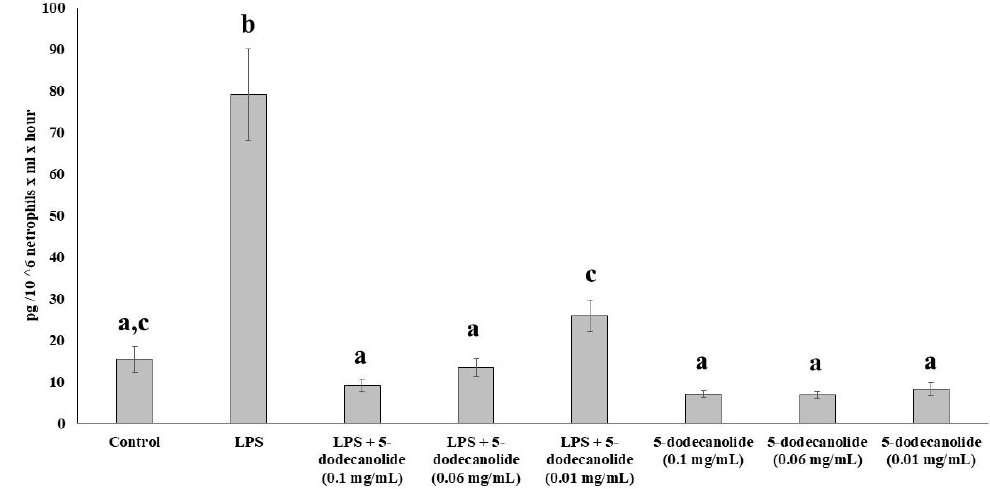
Figure 6. Effects of 5-dodecanolide in neutrophil TNF α production. Statistical analysis: One-way ANOVA test. Different letters indicate significant differences between treatments ( p < 0.05).